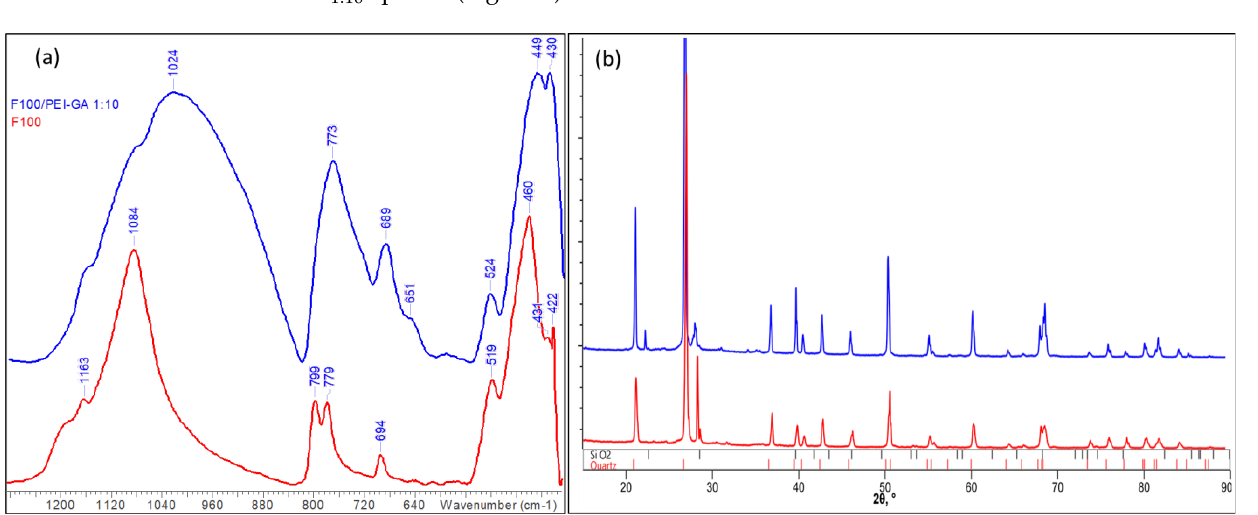
Figure 3. ( a ) FTIR spectra of and ( b ) XRD diffractograms of F100 (red) and F100/PEI-GA 1:10 (blue) microparticles.